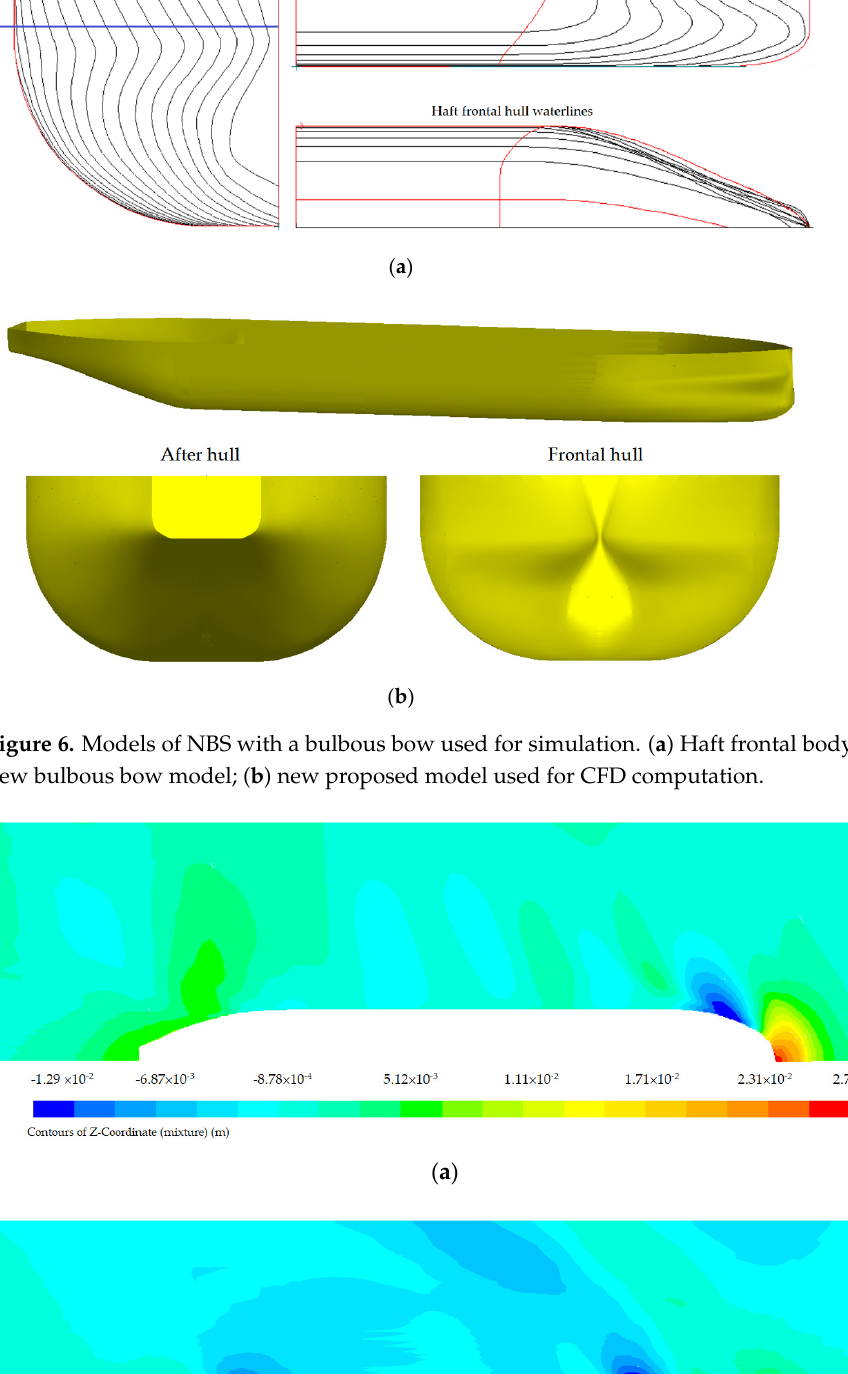
Figure 6. Models of NBS with a bulbous bow used for simulation. ( a ) Haft frontal body plan of the new bulbous bow model; ( b ) new proposed model used for CFD computation. Table 3. Principal dimensions of the bulbous bow model.